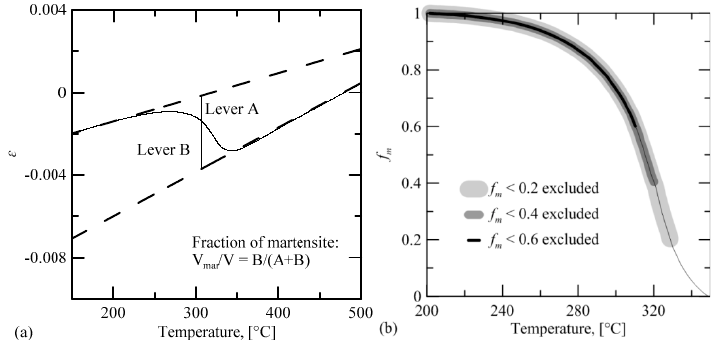
Figure 2. ( a ) The cooling contraction curve around the martensitic transformation. ( b ) The martensite volume fraction with respect to temperature extrapolated from the data shown in ( a ).